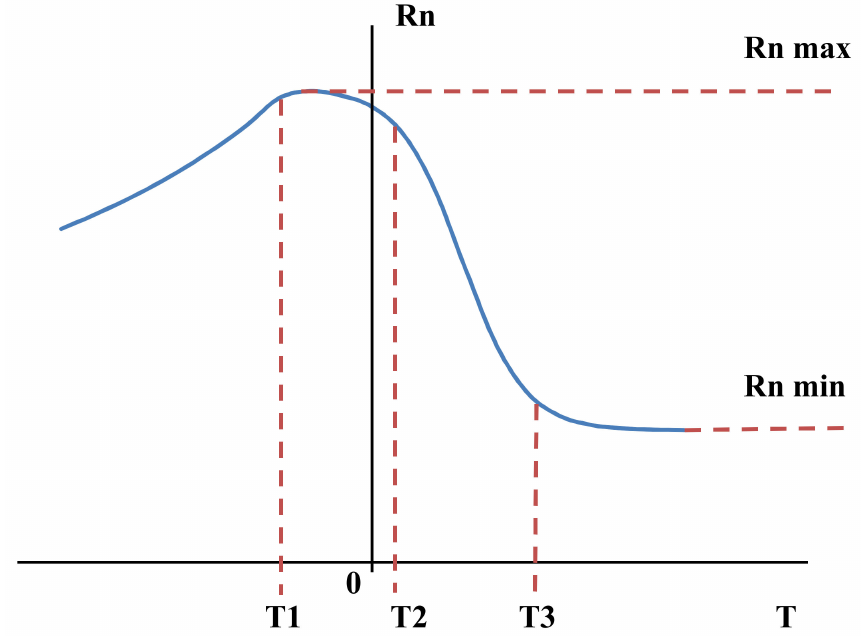
Figure 4. Shape of the suggested model of the dependence of radon concentration in a multistorey building on the outdoor air temperature. (T > T3 summer period, T2 < T < T3 demi-season period, T < T2 winter period, T < T1 cessation of controlled